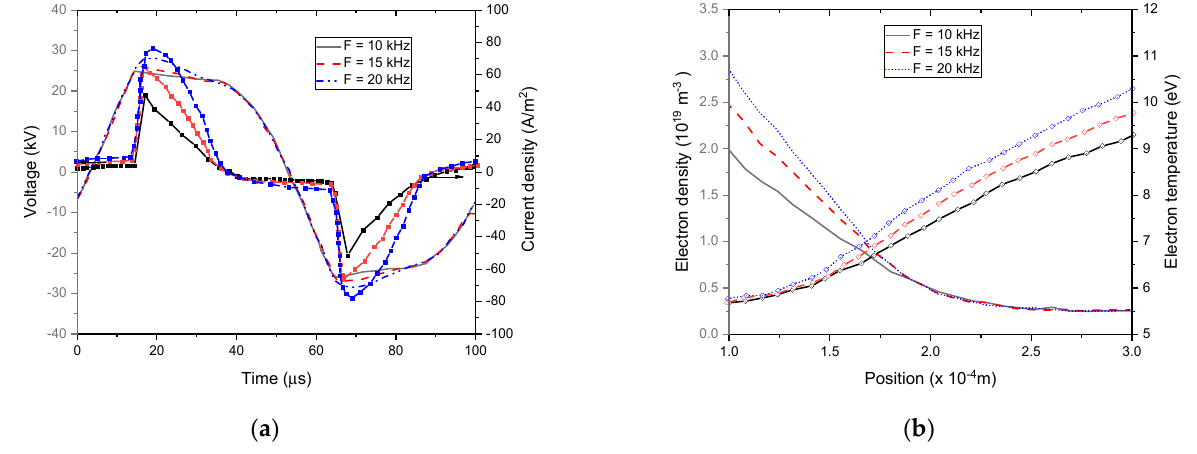
Figure 12. Spatiotemporal distribution of the electron density ( a ) and temperature ( b ) versus the gap extension.